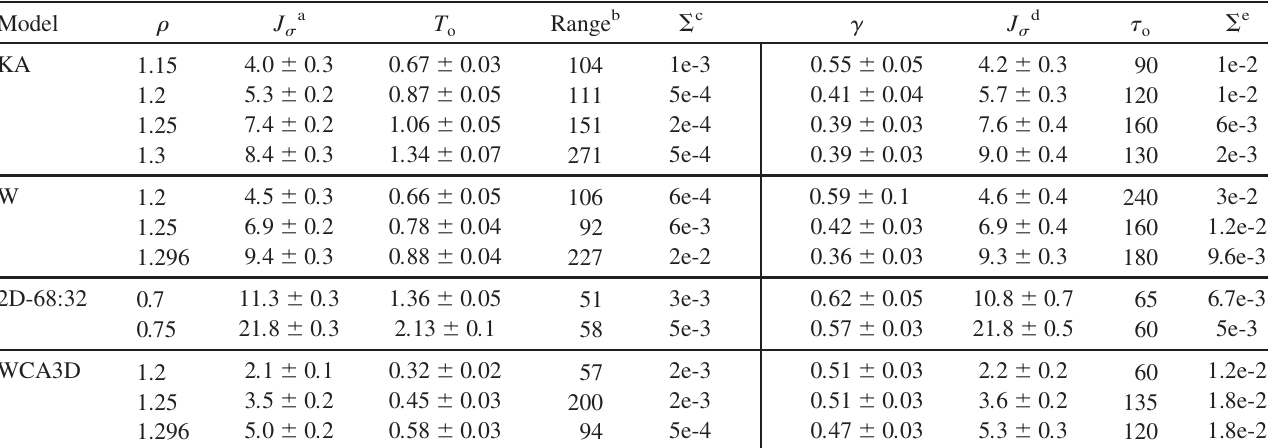
TABLE II. Parameters for data collapse in Figs. 3(d) and 4(a)